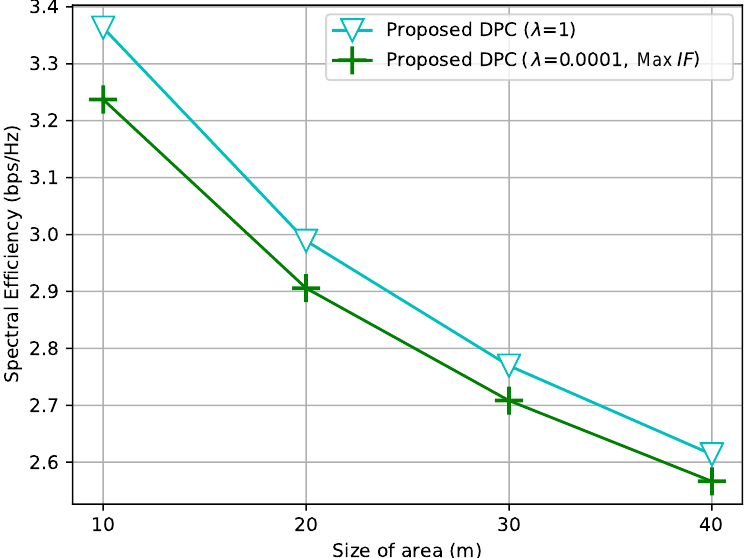
Figure 7. Average spectral efficiency of the proposed DPC scheme with λ = 1 and 0.0001 in Rayleigh fading